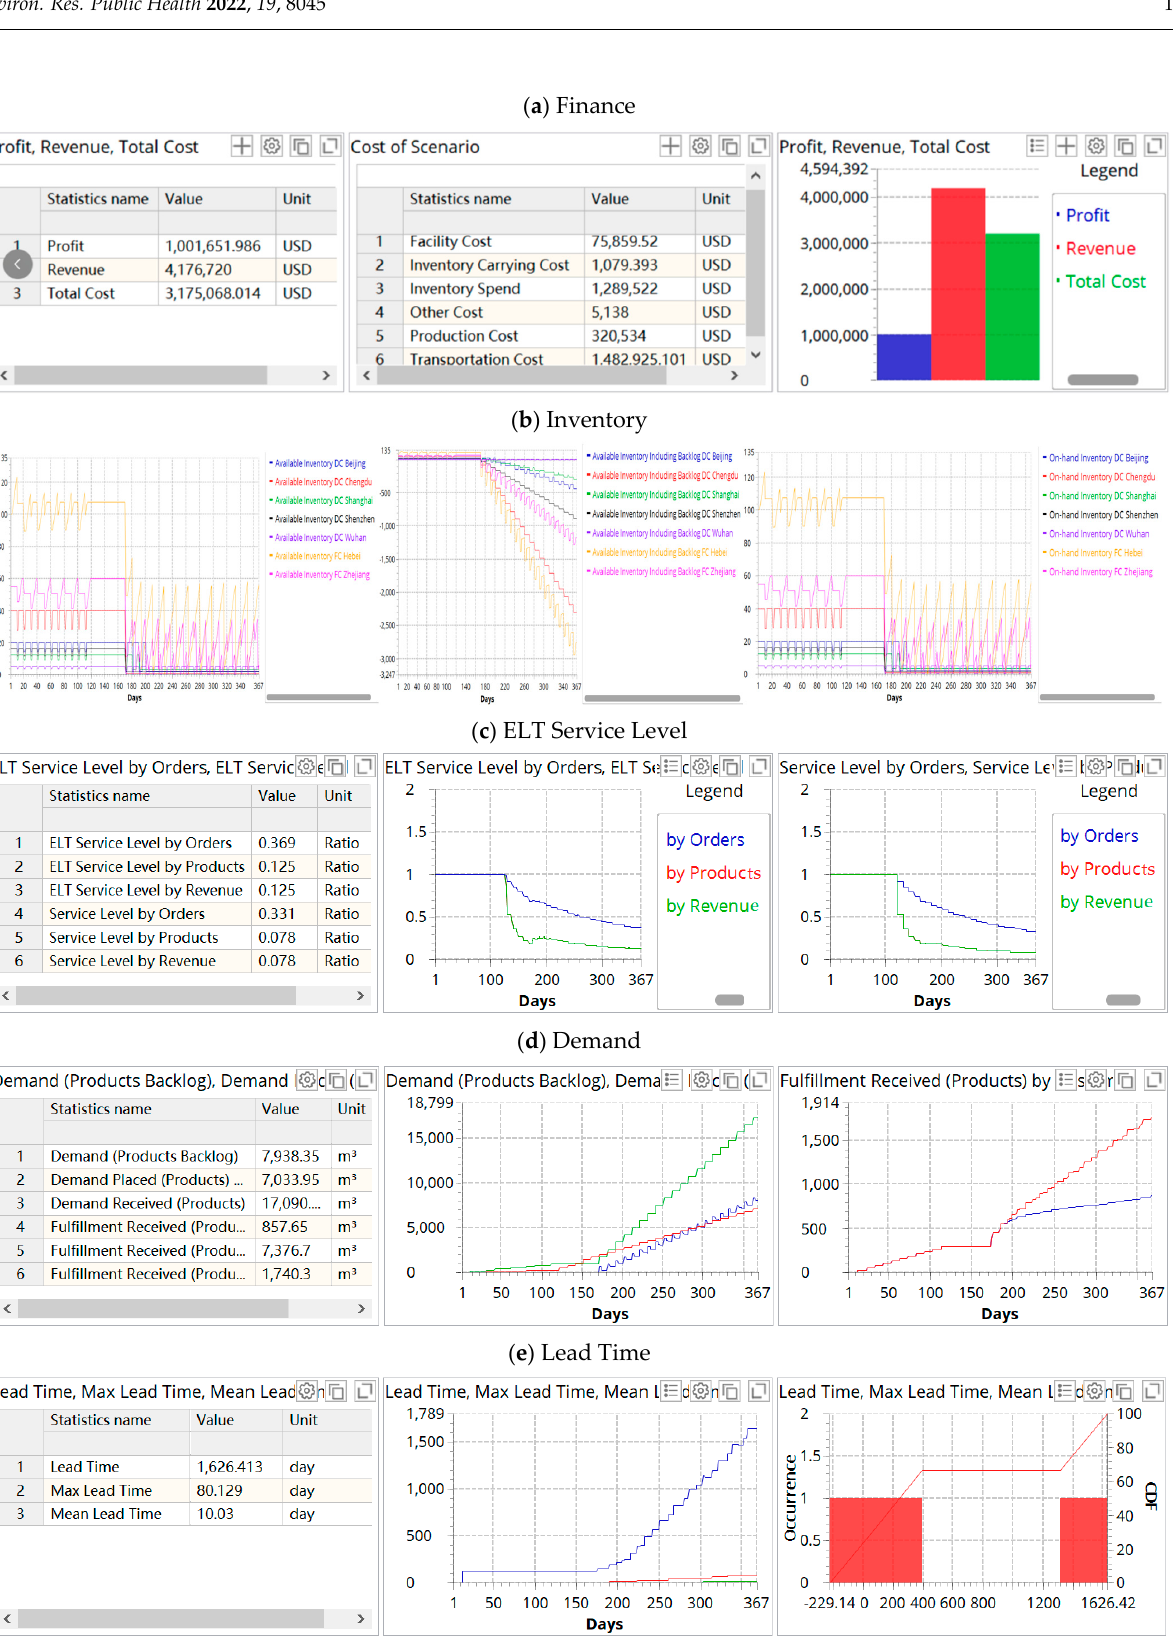
Figure 6. KPIs of the supply chain in Scenario 18. ( a ) Finance; ( b ) inventory; ( c ) ELT service level; ( d ) demand, where the titles are Demand (Products Backlog), Demand Placed (Products) by Customer ( left ), Demand Received (Products), Fulfillment Received (Products On—time) ( middle ), Fulfillment Received (Products), Fulfillment Received (Products) by Customer ( right ); ( e ) lead